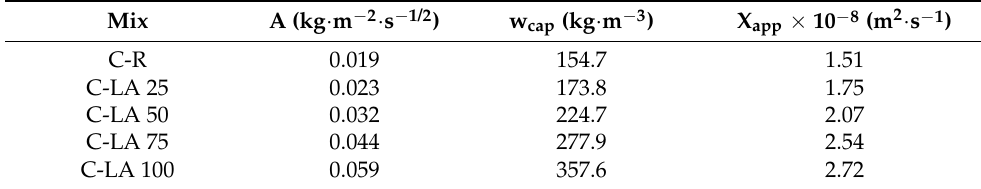
Figure 8. Critical pore size (d cr ) development with regard to LBW content in concretes. Table 6. One-dimensional liquid water transport